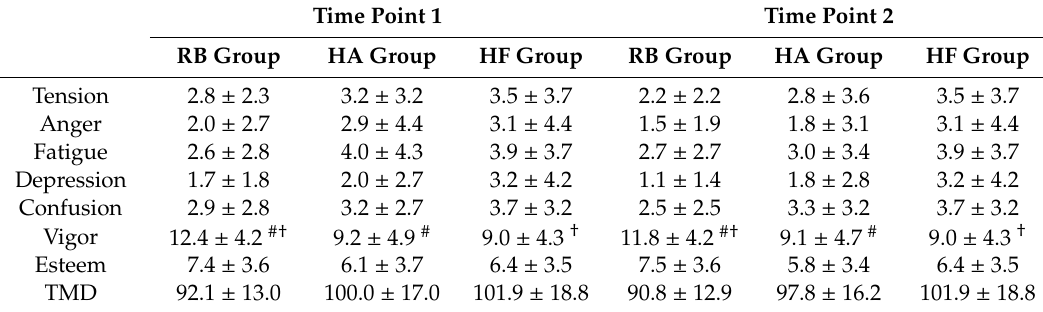
Table 4. Comparison of mood states at di ff erent time points for di ff erent groups ( x ±